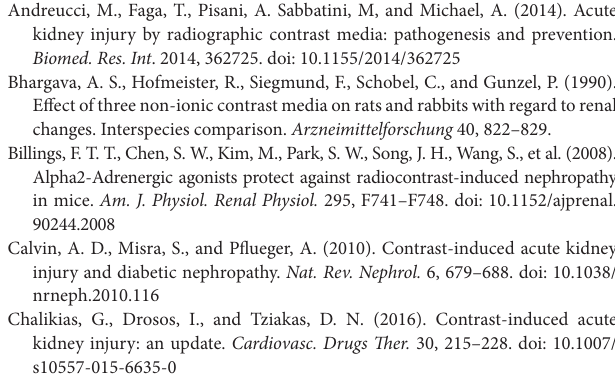
FIGURE S3 | Experimental flow chart for the in vitro model of contrast-induced kidney cell injury in